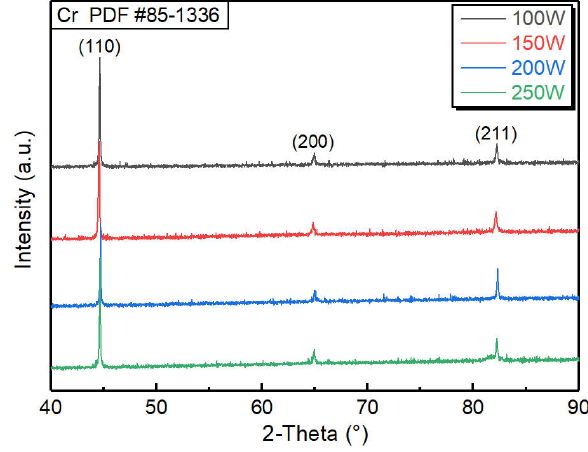
Figure 3. XRD pa tt erns under di ff erent powers. Figure 3. XRD patterns under different